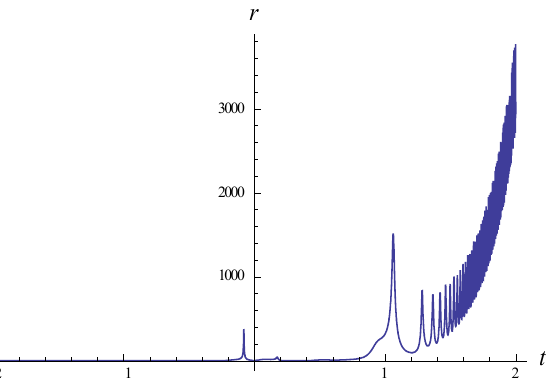
Figure 9. Profile at the position x = 0 of space–time of dynamical evolution of solution determined by Equation (96) with κ 1 ( 0 ) = 0.5, κ 2 ( 0 ) = − 1, α = t − 1, β = 1, γ = t + 1 and δ ( t ) = i